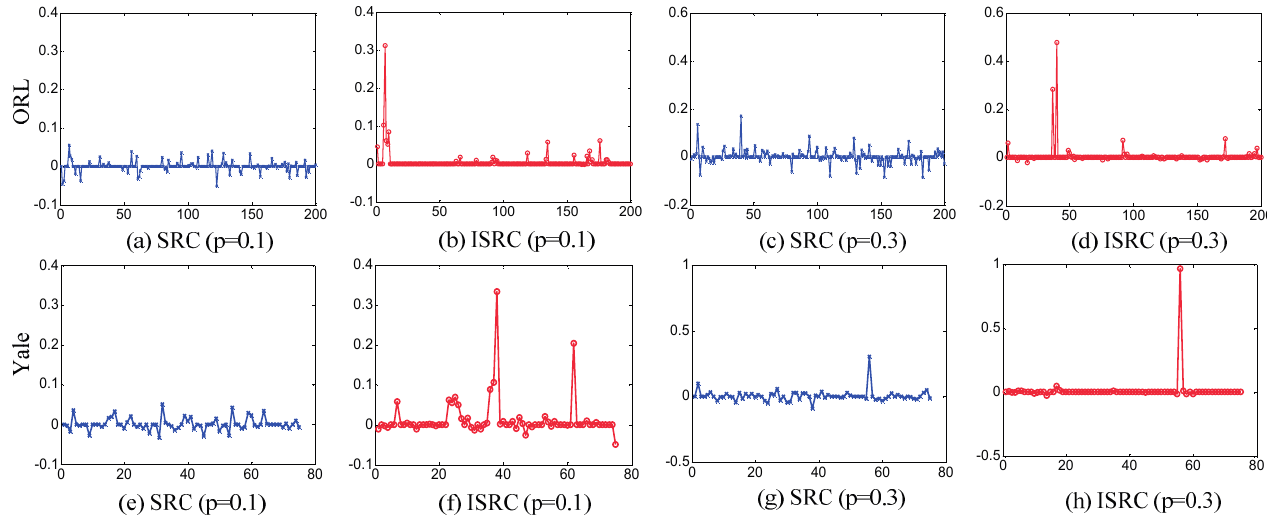
Figure 1. Sparsity comparisons of the linear representations between SRC and ISRC.